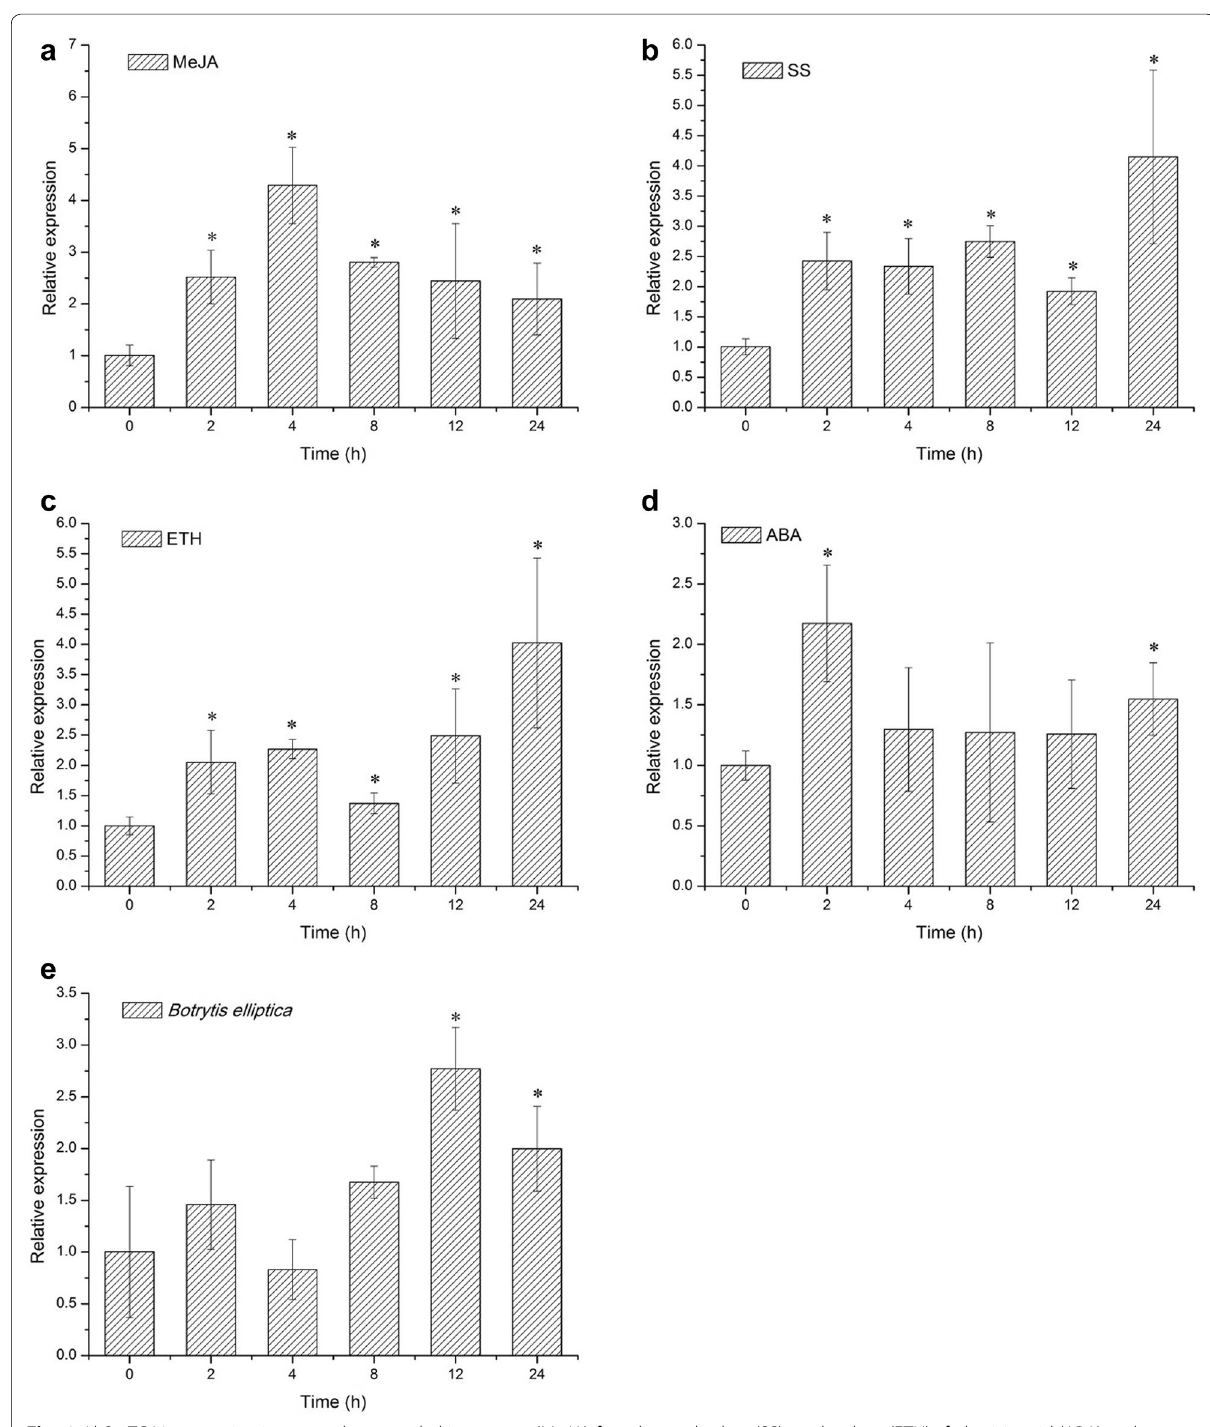
Fig. 6 LhSorTGA2 expression in respond to a methyl jasmonate (MeJA), b sodium salicylate (SS), c ethephon (ETH), d abscisic acid (ABA) and e Botrytis elliptica inoculation treatments. Foliar spray of MeJA, SS, ETH, ABA, or Spores of B. elliptica (8 lily seedling. Leaves were sampled 0, 2, 4, 8, 12, 24 h post treatments to explore LhSorTGA2 expression. Expression at 0 h was used as the calibrator (designated as 1.0) to determine the relative expression of the target gene at different time points. Values are shown as mean (SD) for three replicates. Bars labeled with an asterisk indicate significant differences from the control (0 h) at P < 0.05 (the REST statistical randomi- zation